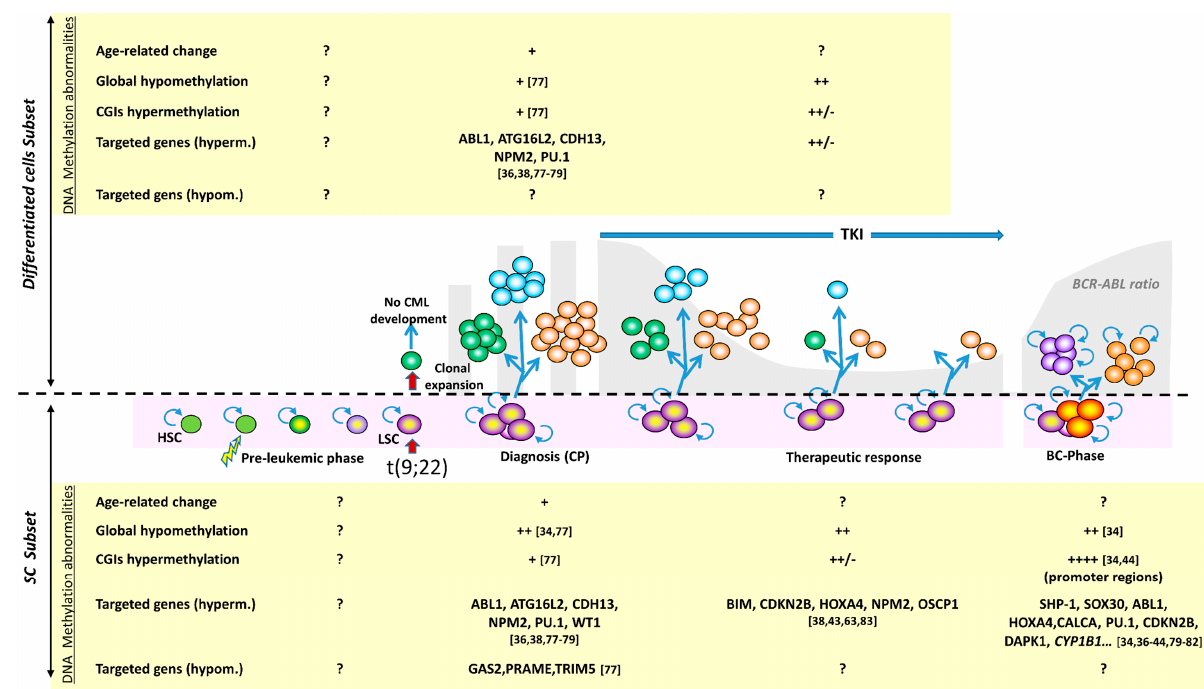
Figure 3. Major methylation alterations in the mature and immature cell compartments during CML course. The longitudinal history of CML is shown with all possible phases: pre-leukemic phase, leukemic transformation of a hematopoietic stem cell (HSC), clonal amplification and diagnosis in the chronic phase, TKI treatment, and blast transformation (now a rare event). A distinction is made between immature cells (SC subset) and mature cells (differentiated cell subset). The most remarkable methylation alterations are indicated for both compartments; when these changes concern the whole clone, without distinction between subsets, the information is indicated for the differentiated cell compartment. For the blast phase, information is provided in the context of immature cells, taking into account the acquisition of stem cell-like characteristics by the progenitors (symbolized by the self-renewal symbol). Only few predisposing factors are known (exposure ionizing radiation, benzene); the set of initial oncogenic factors is symbolized by the lightning arrow. The pre-leukemic phase spreads over several years, is very poorly known, and no information on methylation alterations is available. At diagnosis, the DNA methylation profile is abnormal, with global hypomethylation but CGI hypermethylation in CD34+ cells, and a more balanced distribution of hyper- and hypo- methylated genes. DNA hypermethylation of some genes is consistently observed, some of which represent a typical clonal abnormality, such as ABL1 hypermethylation. During treatment, the DNA methylation changes related to therapeutic resistance remain poorly studied and concern few genes. In the blast phase, the DNA methylation profile changes abruptly. While globally maintaining the CP abnormalities, hypermethylation accompanies disease progression. The number of the bibliographic references appears in square